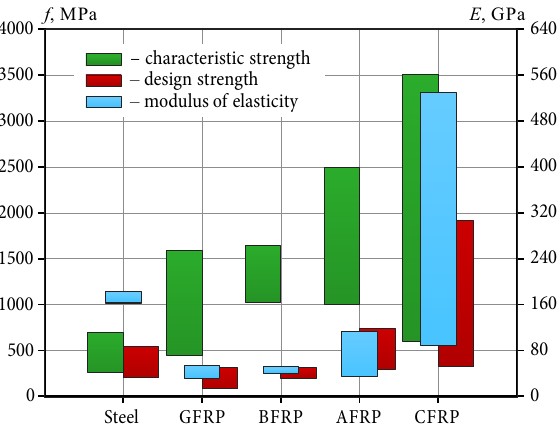
Fig. 6. Comparison of characteristic and design tensile strength and elasticity modulus of different types of reinforcement (Timinskas et al.